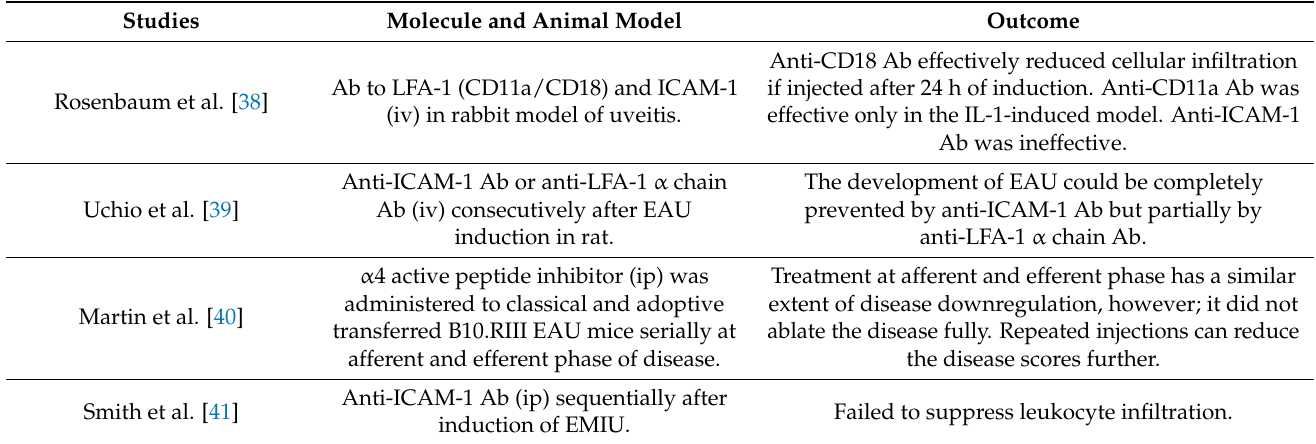
Table 1. Anti-adhesion molecule-based therapy for experimental autoimmune